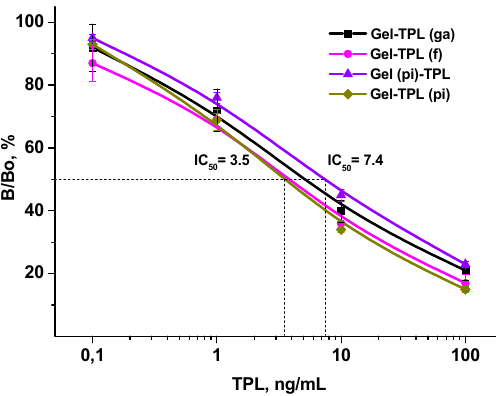
Figure 4. The influence of coating conjugate design (coupling procedure) on teicoplanin (TPL) assay characteristics. The measurements were made in triplicate.